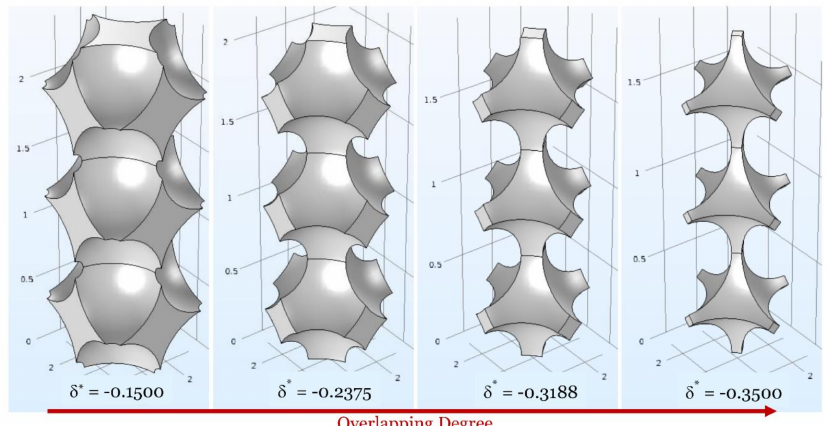
Figure 3. Morphology evolution of the SC structure with increasing overlapping degree. The particular values of δ * are chosen just to better visualise the evolution of the structure.